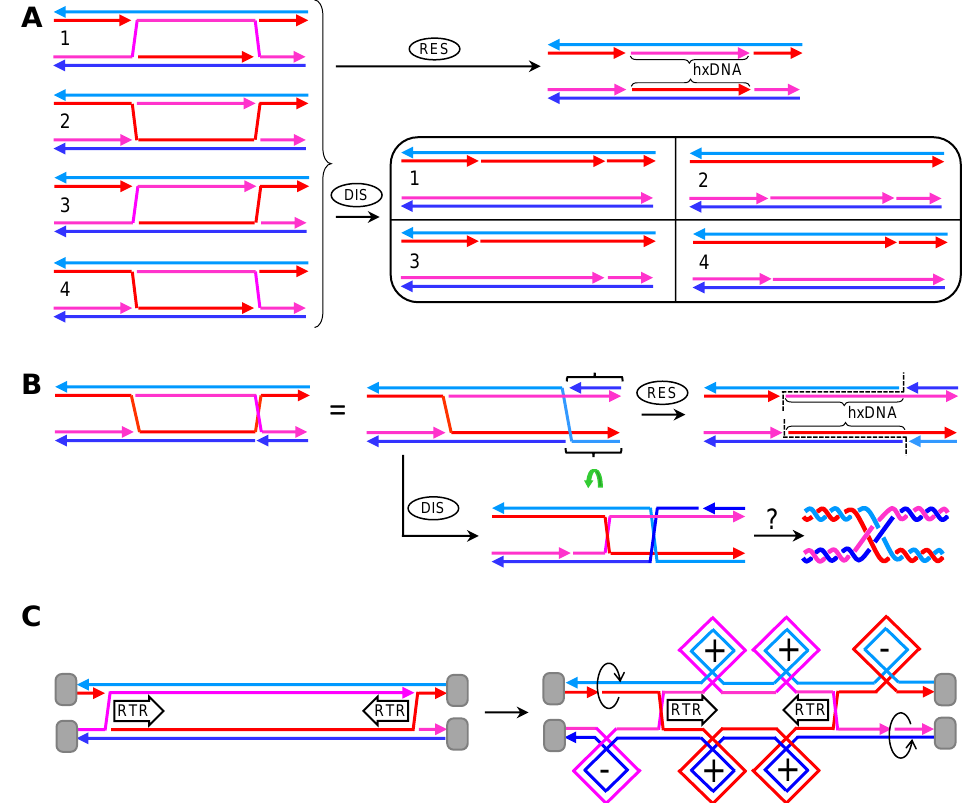
Figure 5. Features of the double nicked Holliday junction (dnHJ). ( A ) 2D straight line schematics of four DPE dnHJ isomers comprising different combinations of nicked strands. In isomer 1 and 2, one out of the four strands carries two nicks. In isomers 3 and 4, Watson strands carry one nick each. All isomers lead to a single resolution (RES) NCO product with hxDNA between the resolved nHJs. In addition, a single pattern of four nicks is expected. Dissolution (DIS) of all isomers lead to NCOs without hxDNA. The relative position of the two nicks is distinct and may serve as a footprint to infer the original dnHJ. ( B ) Two-dimensional schematics of a DPO dnHJ isomer. Since the nHJ isomer with the nick in one of the non-crossover strands is highly unfavorable, the more accurate representation is the one shown in the center, with the right edge vertically flipped to represent the single strand in the cross-join (brackets with the green arched arrow). Resolution leads to a single CO product with hxDNA between the resolved nHJs. Dissolution su ff ers from the problems stated in Figure 4E. ( C ) Converging Branch migration of a dnHJ would lead to dcHJ with the same positive supercoiling issues raised in Figure 4C. However, negative supercoiling could be relieved as a result of the strand swirling at the nicks left behind. For other details see previous figure legends.